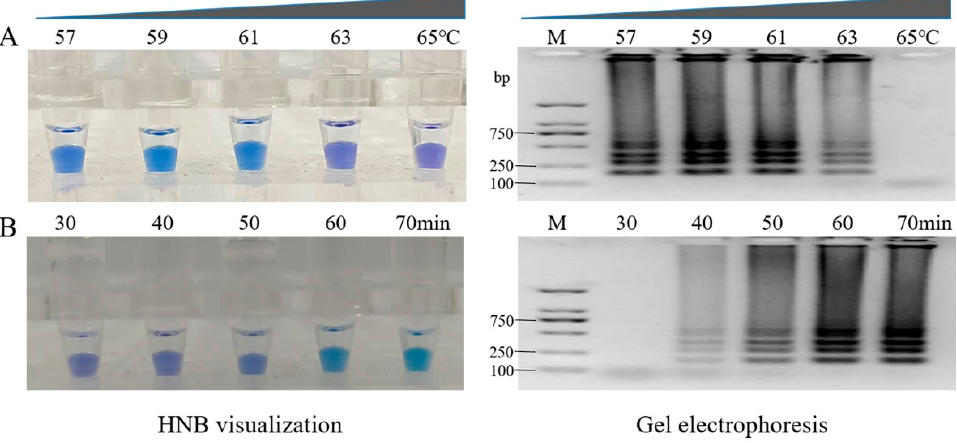
Figure 7. Optimization of temperature ( A ) and time ( B ), respectively of LAMP reaction. M. Trans 2K DNA marker.